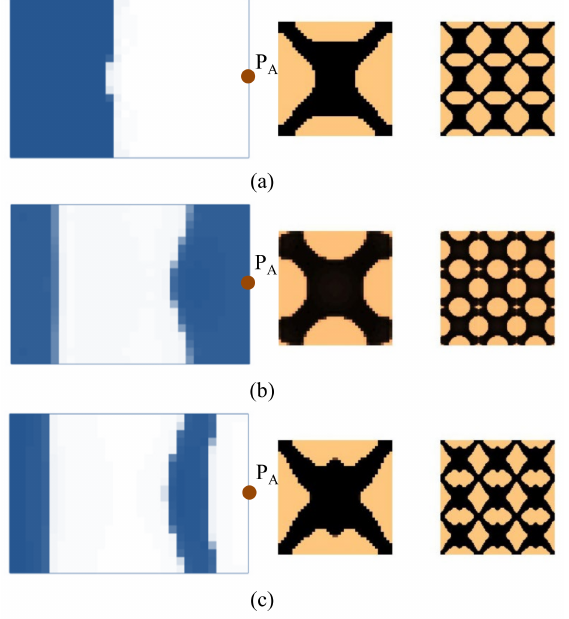
Figure 13. Comparison of three different designs by varying the excitation frequency. ( a ) Excitation